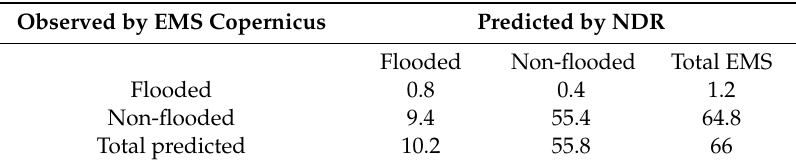
Table 3. Confusion matrix. Data in square kilometers 1 .